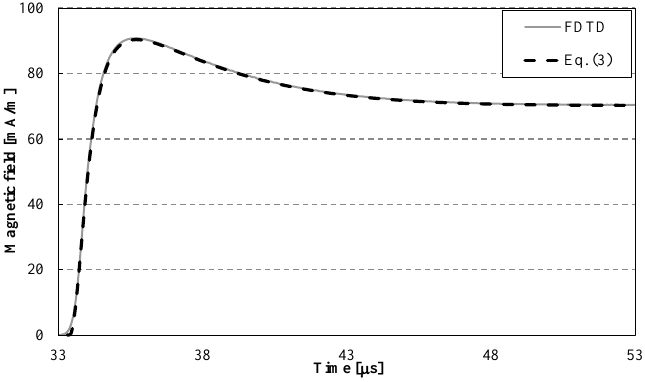
Figure 5. FDTD-computed waveform of total azimuthal magnetic field at an observation point located at (7080 m, 7080 m) and the corresponding waveform computed using Equation (3) (TL model, v = 150 m/μs).